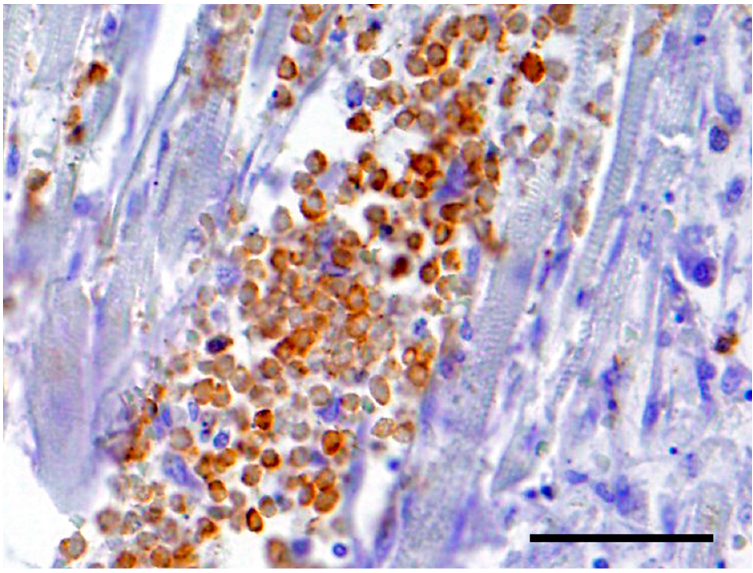
Figure 3. The neoplastic cells in the heart exhibited a diffuse, strong positive cytoplasmic staining for CD3 + . Bar = 50 µm .